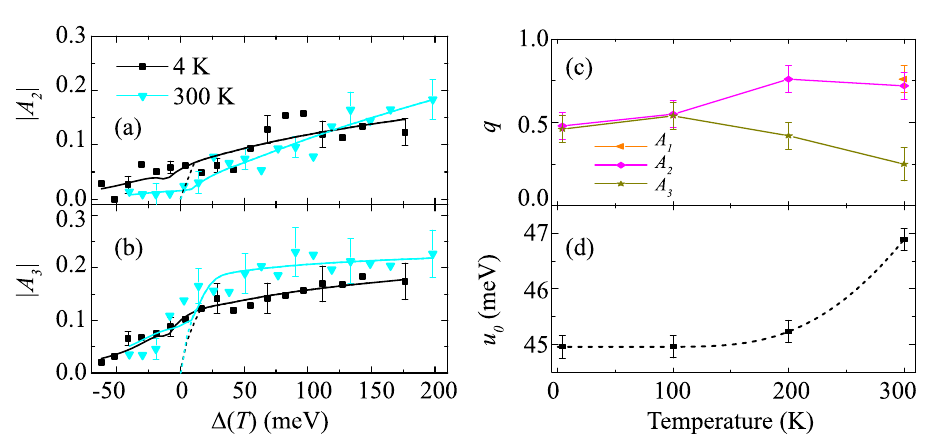
Figure 4. Excess-photon energy dependence of ( a ) | A 2 | and ( b ) | A 3 | at low and high lattice temperatures. Temperature dependence of ( c ) power value, q , to determine the band-to-band excitation transition type and ( d ) Urbach energy, u 0 , for below-gap absorption